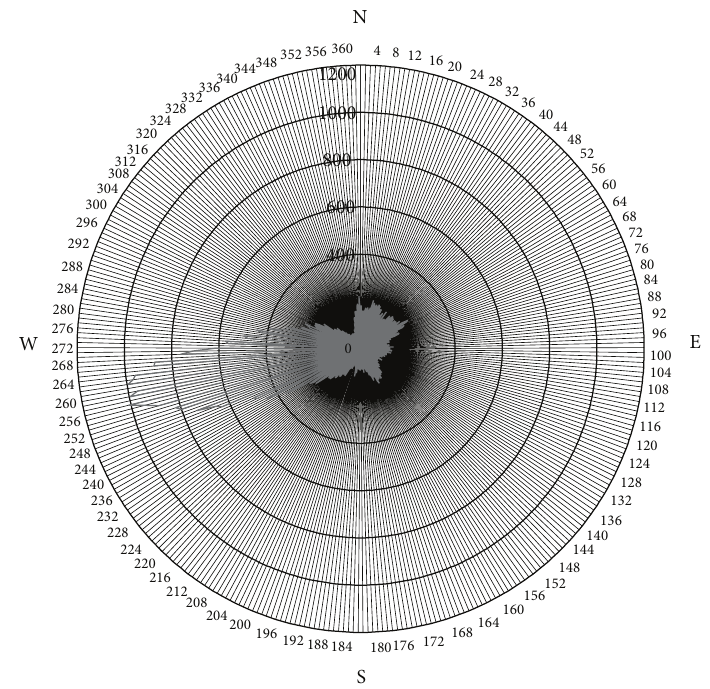
Figure 10: Test case site wind direction frequency.